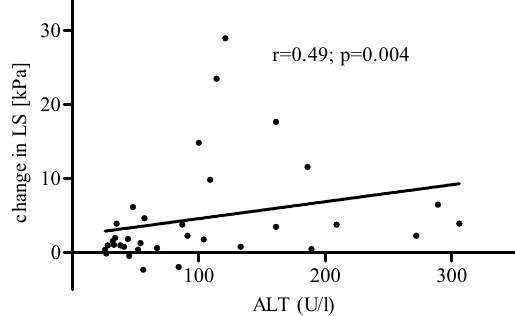
Figure 3. Change in LS after 96 weeks in patients with fibrosis stage F4 and below F4 measured at baseline (unpaired t -test). F0/1–F4: METAVIR scores; LS—liver stiffness; kPa—kilopascal; data presented as mean; whiskers indicate standard deviations.